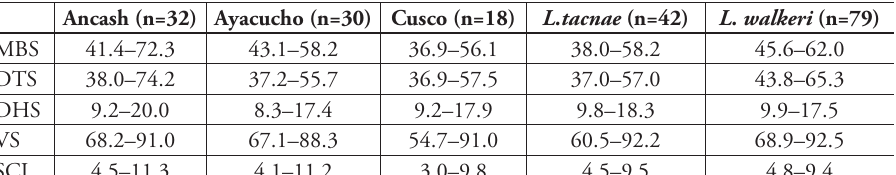
table 4. Normal tolerance intervals for meristic characters of three species of Liolaemus described herein, plus L. tacnae and L. walkeri ; all variables were assumed to follow a normal distribution. See methods for abbreviations.